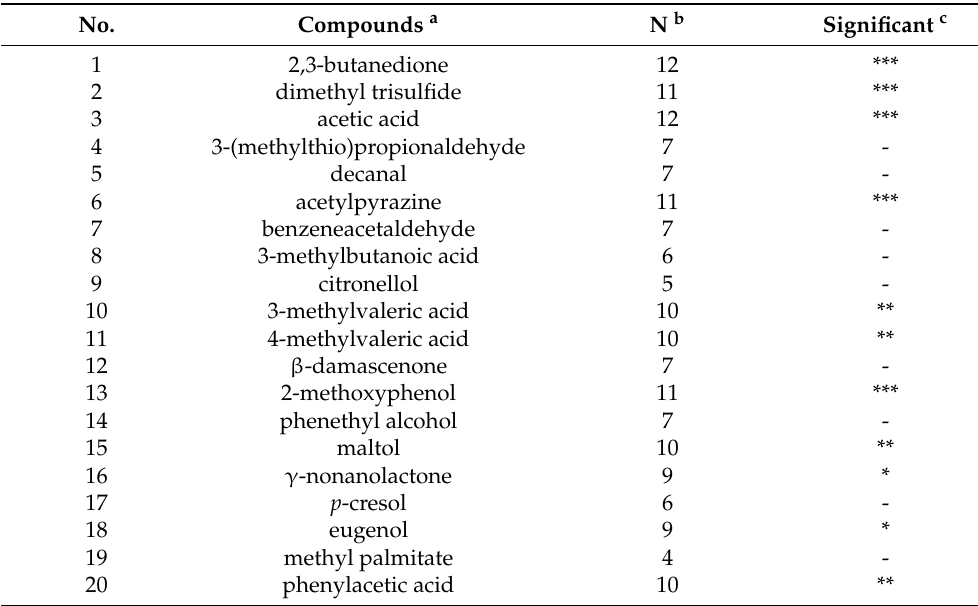
Table 3. Triangle test results of aroma-active compound (OAV > 1) by omission experiments.